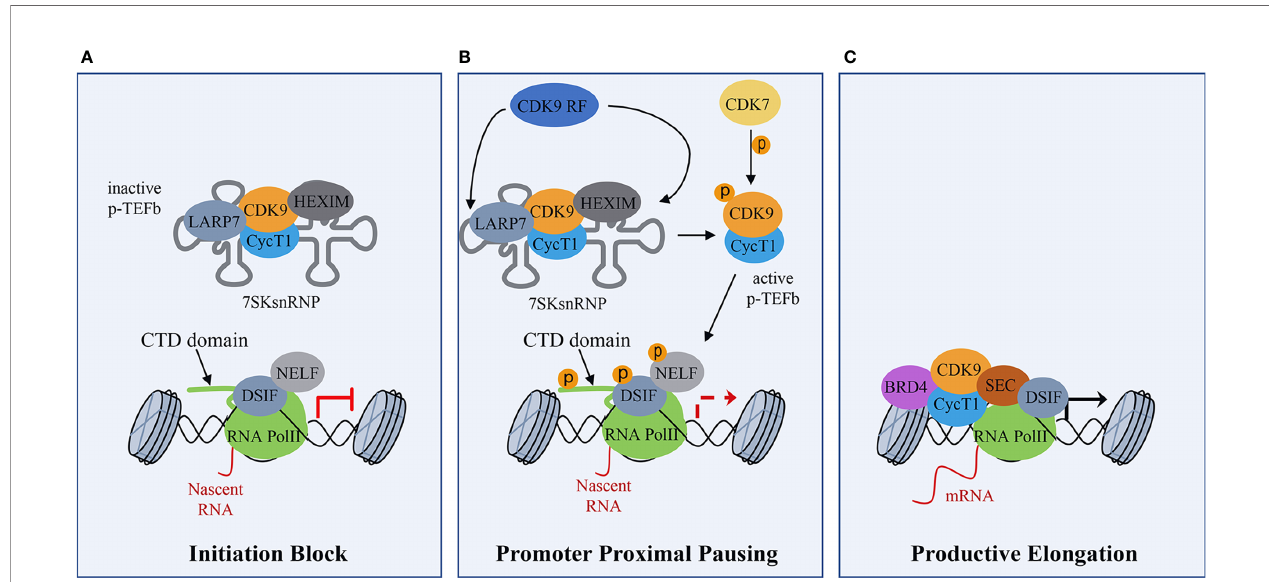
FIGURE 1 | CDK9 function in RNA Pol II activation and gene transcription: (A) CDK9 associates with cyclin T1 (CycT1) forming the positive transcription elongation factor b (P-TEFb) complex. The P-TEFb complex is inactive when incorporated into the 7SK small nuclear ribonucleoprotein complex (snRNP) which includes HEXIM. LARP7 interacts with 7SKsnRNP to increase complex stability. RNA polymerase II (RNA PolII) is loaded with the negative elongation factors negative elongation factor (NELF) and DRB sensitivity-inducing factor (DSIF), blocking transcription elongation. (B) Upon transcriptional stimuli, CDK9 release factors (CDK9 RF) post- translationally modi fi es the 7SKsnRNP/P-TEFb complex to promote the release of P-TEFb. To this process concurs the activation/phosphorylation of CDK9 by CDK7, which works as a CDK activating kinase (CAK). Active P-TEFb complex, in turn, phosphorylates DSIF and NELF and the Ser2 of the RNA PolII C terminal domain (CTD) at target promoters to remove elongation blocks. (C) Bromodomain protein 4 (BRD4), which is recruited by transcription factors on promoters of target genes that must be activated, recruits, in turn, activated P-TEFb and super elongation complex (SEC) allowing transcriptional elongation and expression of target